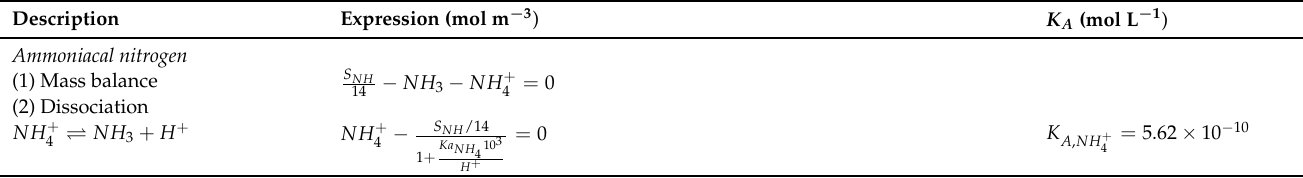
Table A1. pH submodel algebraic equation system: mass balances and dissociation